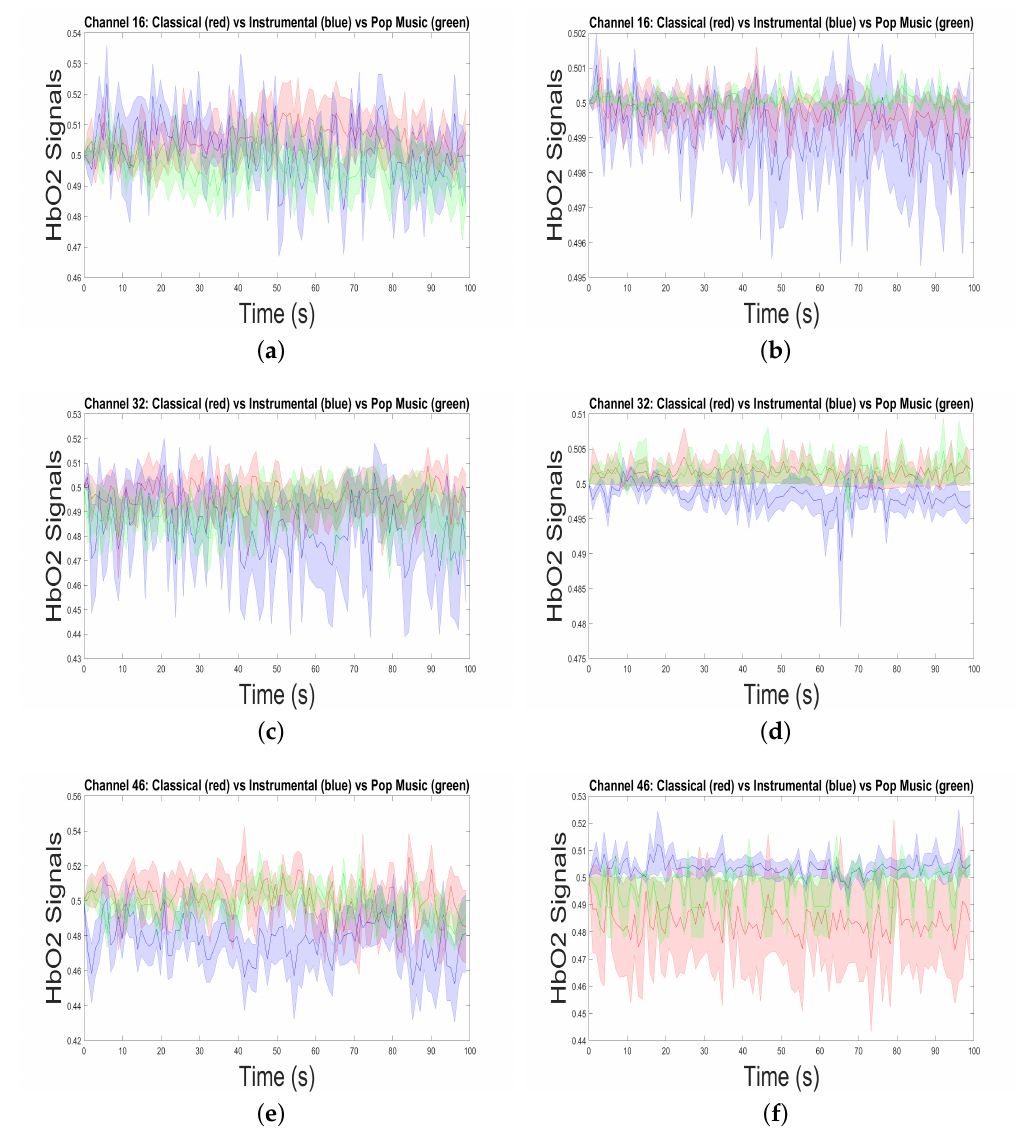
Figure 6. Timeline Analysis of Participants HbO2 Response to Three Music Genres. ( a ) Channel 16: 900–1000 points. ( b ) Channel 16: 2500–2600 points. ( c ) Channel 32: 900–1000 points. ( d ) Channel 32: 2500–2600 points. ( e ) Channel 46: 900–1000 points. ( f ) Channel 32: 2500–2600